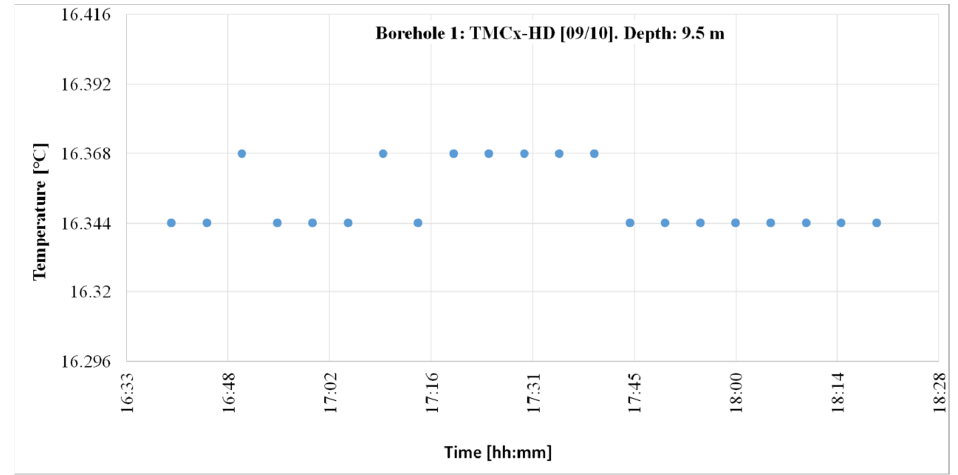
Figure 25. Temperature registered on 9 October 2012 at the “Q-Thermie-Uniovi-1” borehole with TMCx-HD sensors.